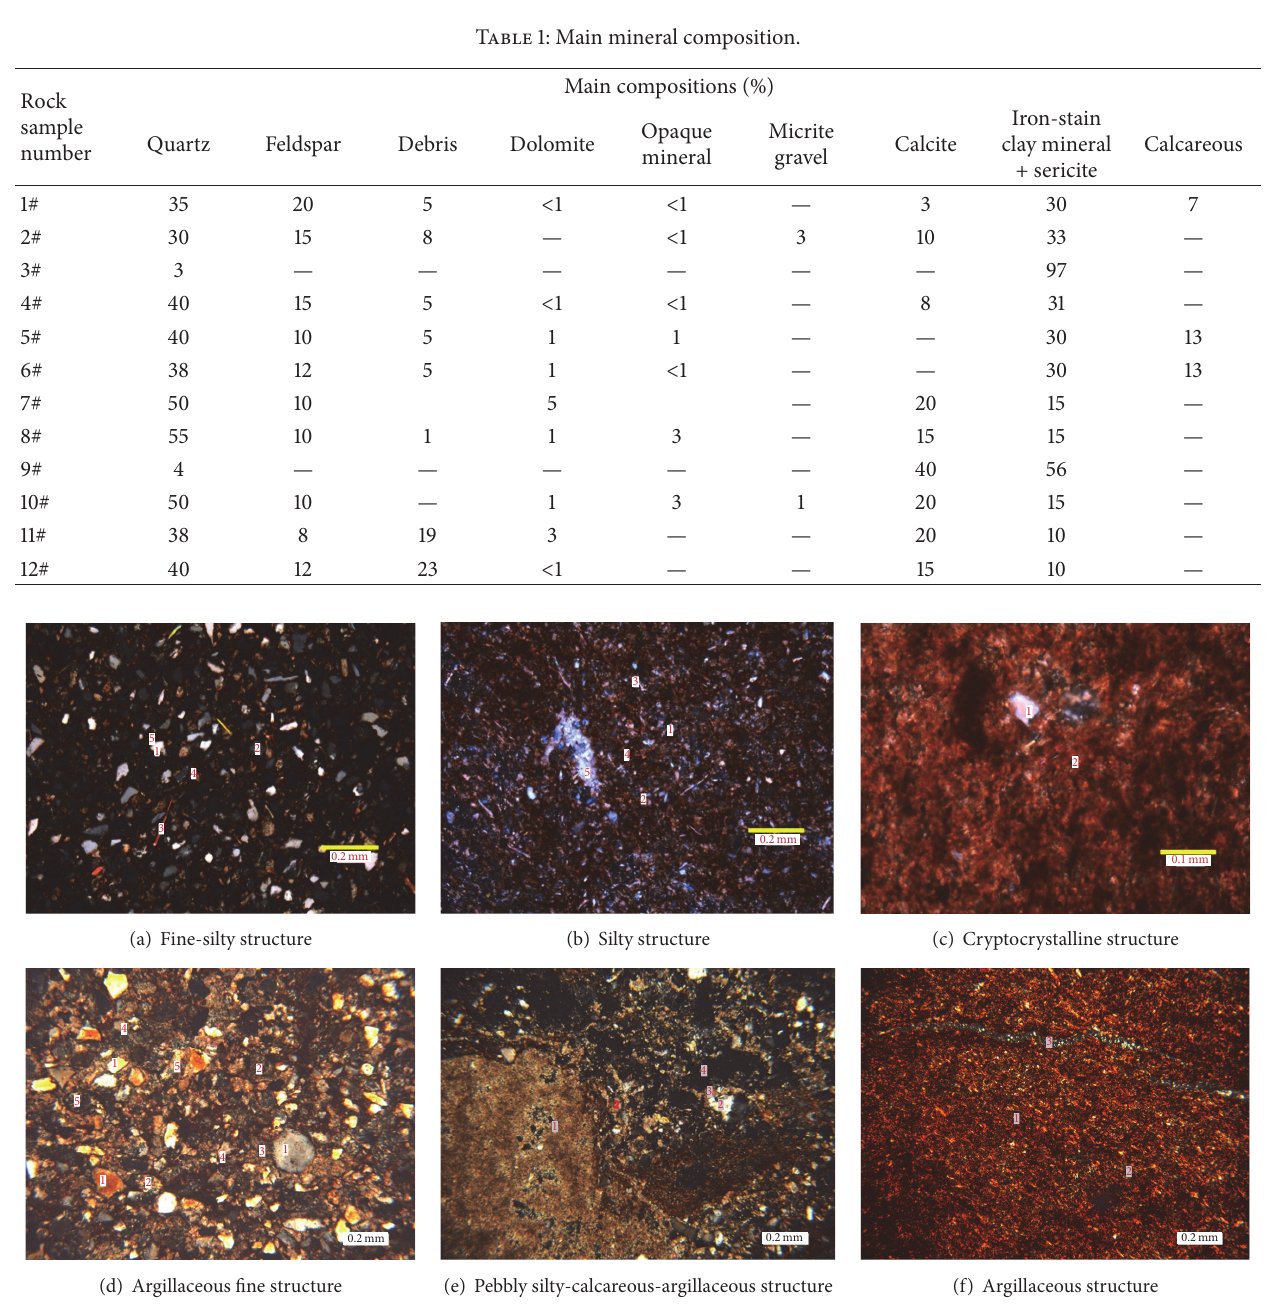
Figure 2: Microscopic structure diagram of representative red-bed soft